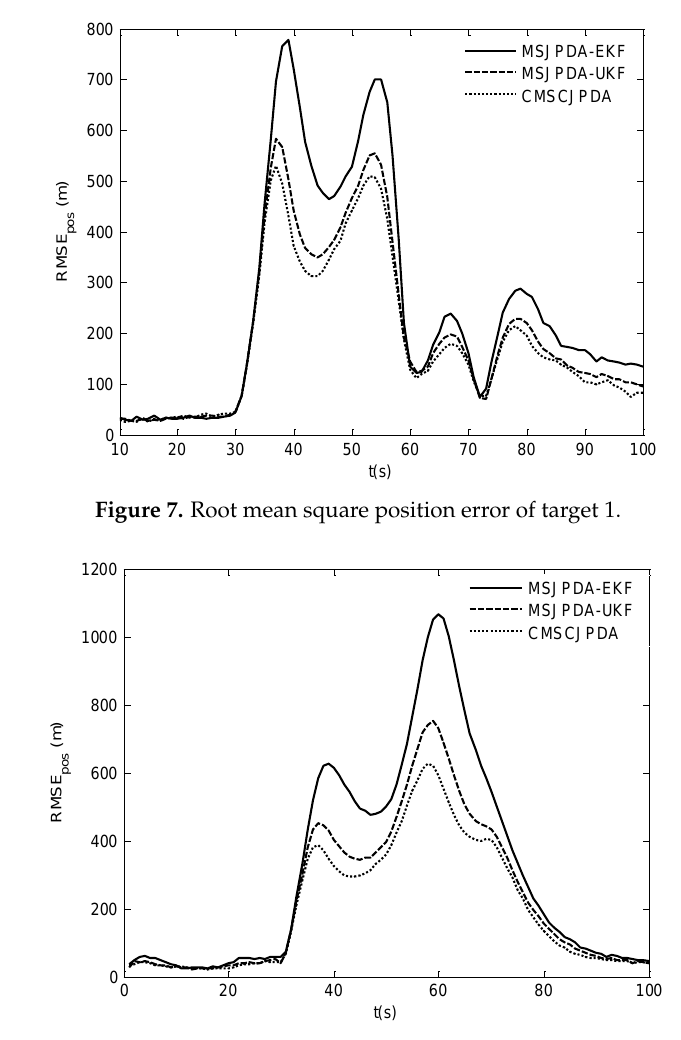
Figure 8. Root mean square position error of target 2.